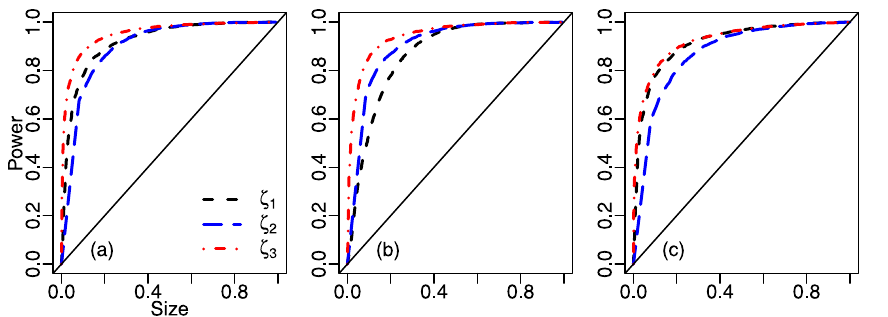
Fig 2. Size-power plots, KW ð ω ; ϕ Þ , n = 100; panel (a): KW ð 0 : 2 ; 7 : 5 Þ , panel (b): KW ð 0 : 5 ; 15 Þ , panel (c): KW ð 0 : 75 ; 25 Þ .